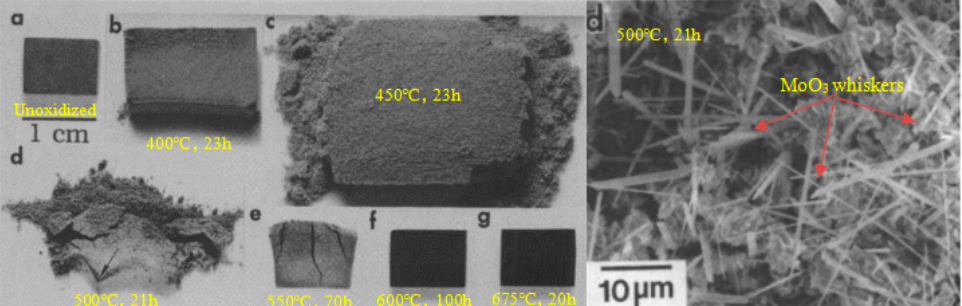
Figure 5. Variation of MoSi 2 sample morphology with oxidation temperature and oxidation